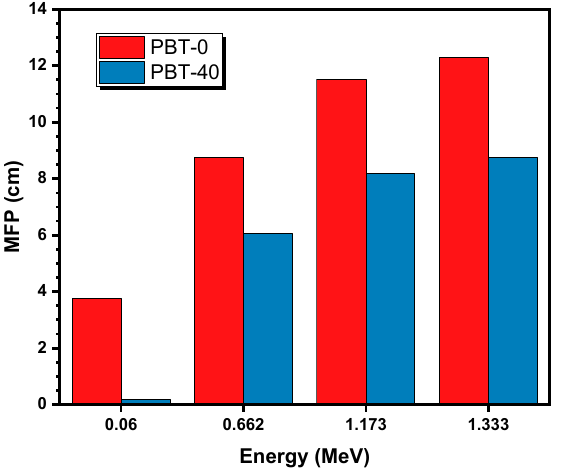
Figure 6. The mean free path (MFP) of the PBT-0 and PBT-40 polymer samples. The effective atomic number (Z eff ) of the five investigated polymer samples are graphed in Figure 7. Because of the radioisotopes used in this study, the radiation shielding parameters could only be reported at four energies. In order to examine the shielding properties at a wide energy range, the Z eff of the current polymers was calculated between 0.015 and 15 MeV. First, a spike in the values occurs around 0.030 MeV, which is due to the K-absorption edge of Te (this is evident by the fact that no spike occurs for PBT-0, which contains no Te). Aside from this rise in values, at low energies, the Z eff values of all five samples decrease with increasing energy. Meanwhile, in the middle energy range, the values stay mostly constant, and at higher energies, they increase. For example, PBT-10’s Z eff values are 21.26 at 0.015 MeV, 18.88 at 0.050 MeV, 8.64 at 0.100 MeV, 5.07 at 0.500 MeV, 5.08 at 3 MeV, and 6.03 at 15 MeV. In addition, the Z eff values increase as the TeO 2 content in